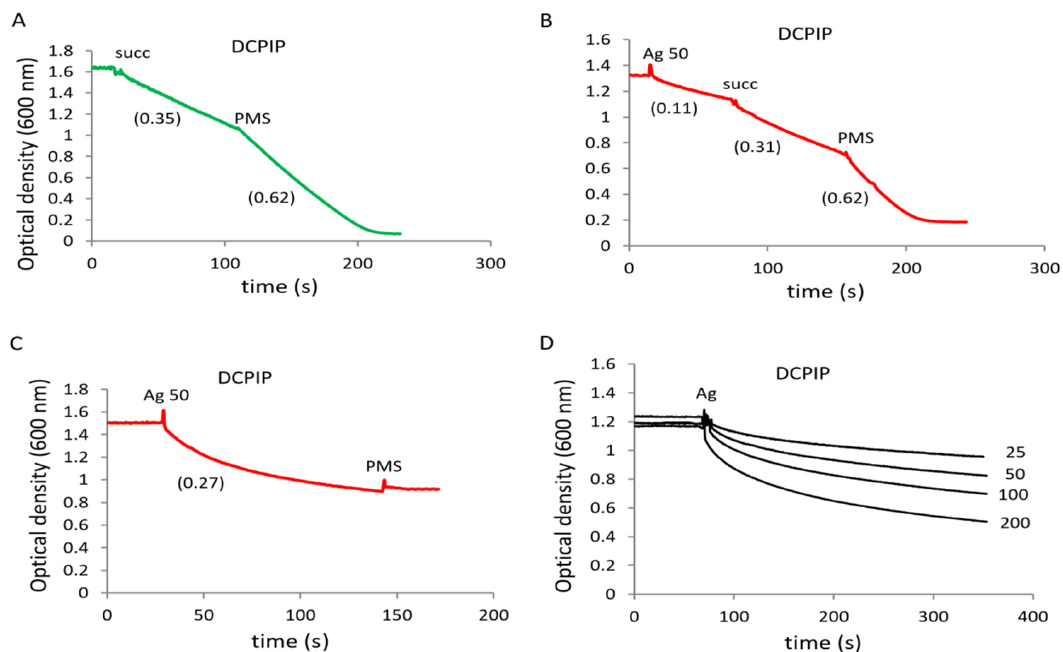
Figure 3. Influence of agrimoniin on succinate dehydrogenase activity. SDH activity in rat liver mitochondria (1 mg protein/mL) was determined by DCPIP reduction in control ( A ) and in the presence of 50 µM agrimoniin ( B ). DCPIP reduction was induced by succinate (5 mM) addition and was activated by PMS (100 µM) addition. DCPIP reduction by 50 µM agrimoniin ( C ) and in the range of concentrations 25–200 µM ( D ) in buffer medium without mitochondria.